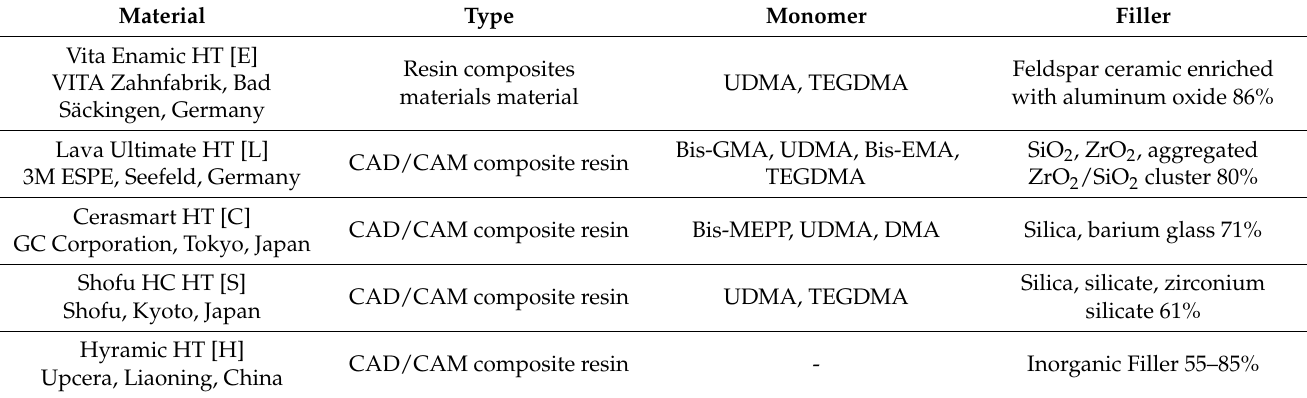
Table 1. Composition and manufacturer specifications of tested materials